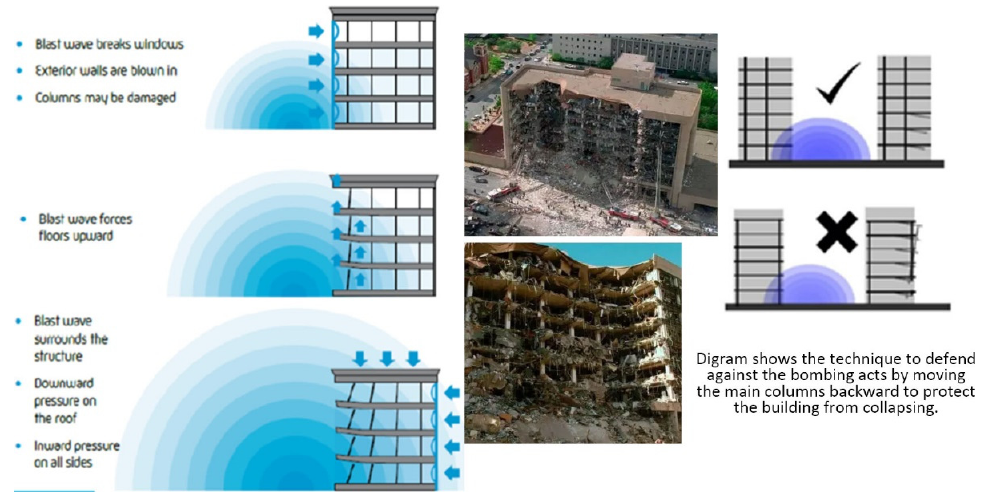
Figure 4. Diagram showing the expected different effects of a bomb blast on the building envelope such as the blast wave forces affecting the elevations and downward pressure affecting the roofs, causing the building’s destruction. Source: (Y.M.).